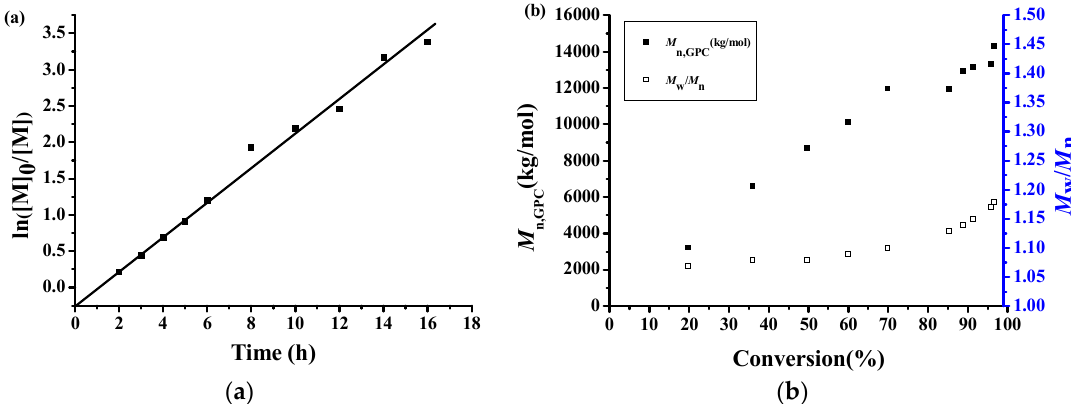
Figure 3. In([M] 0 /[M]) as a function of ( a ) time and ( b ) number-average molecular weight ( M n,GPC ) and molecular weight distribution ( M w / M n ) versus monomer conversion for TPSC-based ICAR ATRP of MMA. [MMA] 0 /[EBPA] 0 /[CuBr 2 ] 0 /[TPMA] 0 /[AIBN] 0 = 200:1:1:3:0.8, V MMA = 1.0 mL, V benzene = 3.0 mL, m PIL = 200 mg and, temperature = 70 °C.